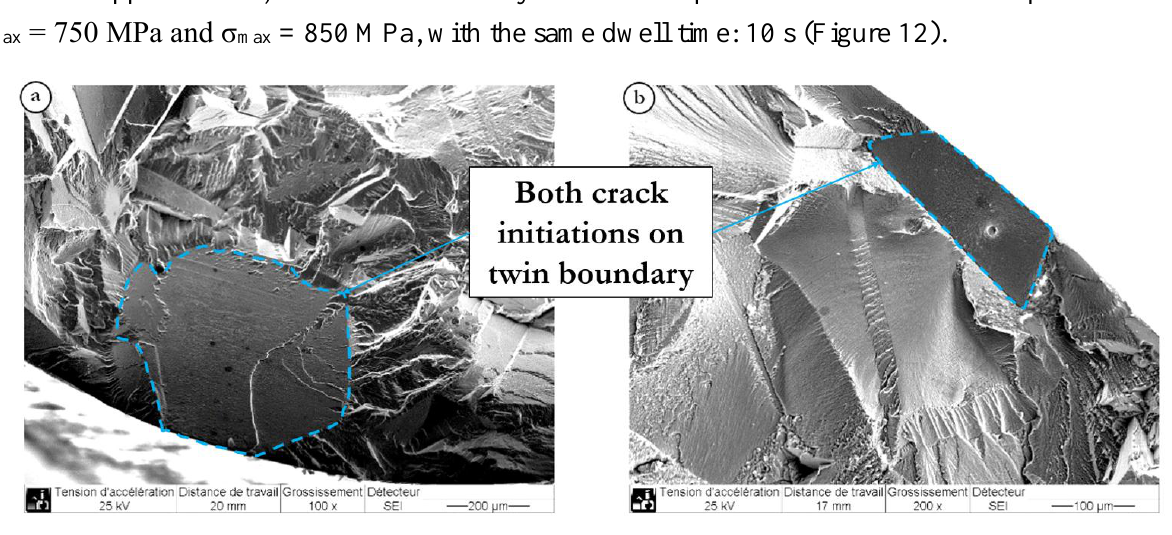
Figure 12. Fracture surface observations of creep-fatigue specimens: coarse grains microstructure, 700 °C—Δ t = 10 s; ( a ) σ max = 750 MPa; ( b ) σ max = 850